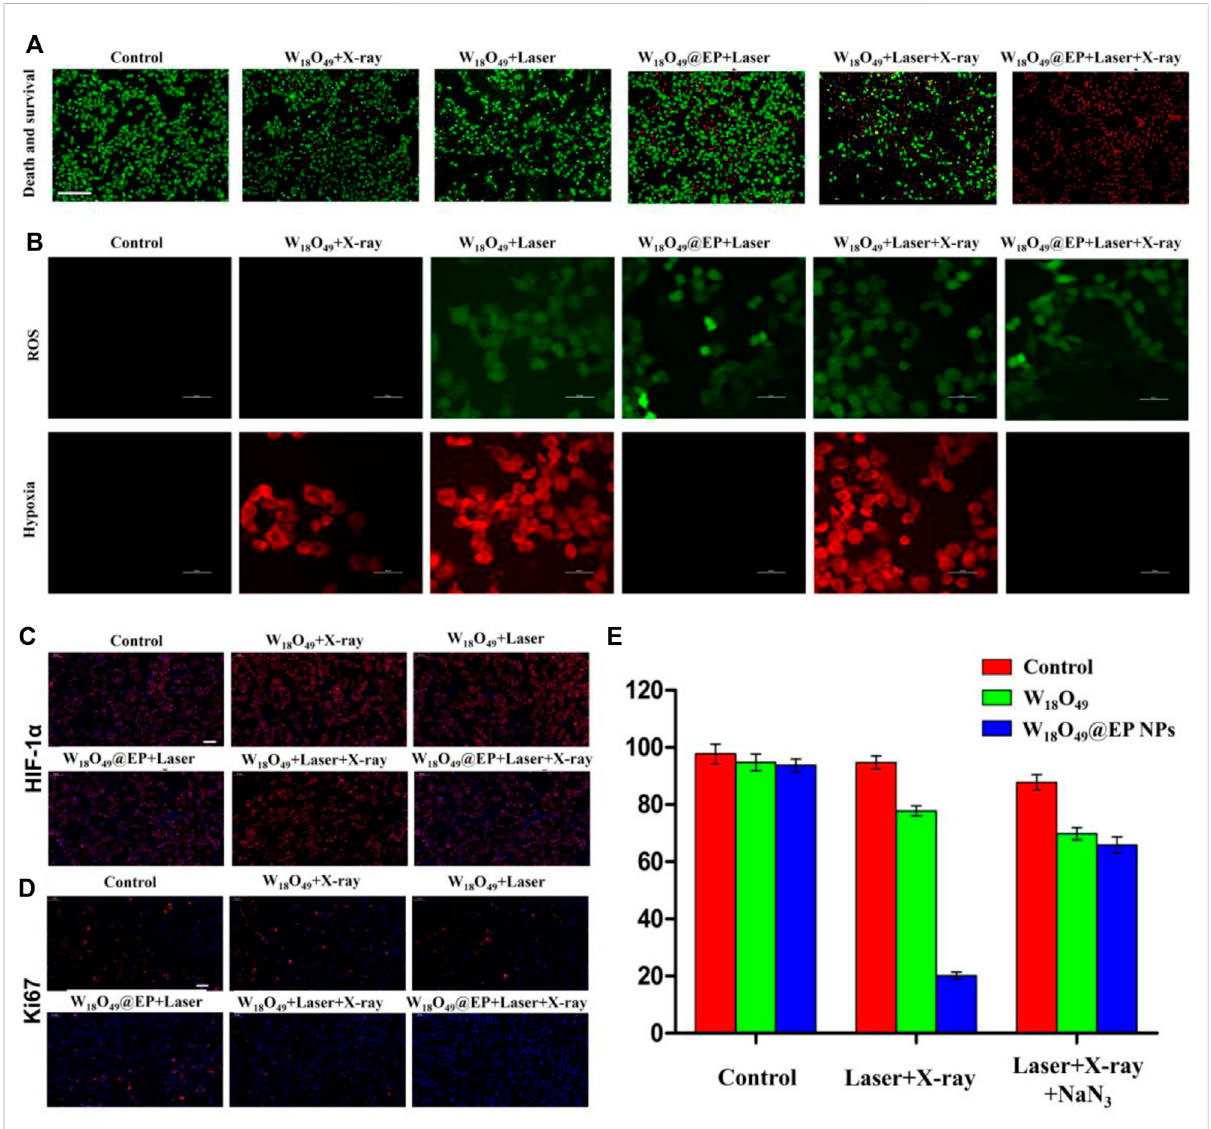
Anti-tumor experiment in vitro . (A) Cell death after different treatments. Red: dead cells; green: living cells. (B) Intracellular ROS content and hypoxia status after different treatments. (C) HIF-1 expression in cells after different treatments. HIF-1 is marked with red fl uorescence. (D) Ki67 expression in cells after different treatments. Ki67 is marked with red fl uorescence. (E) Cell survival after different